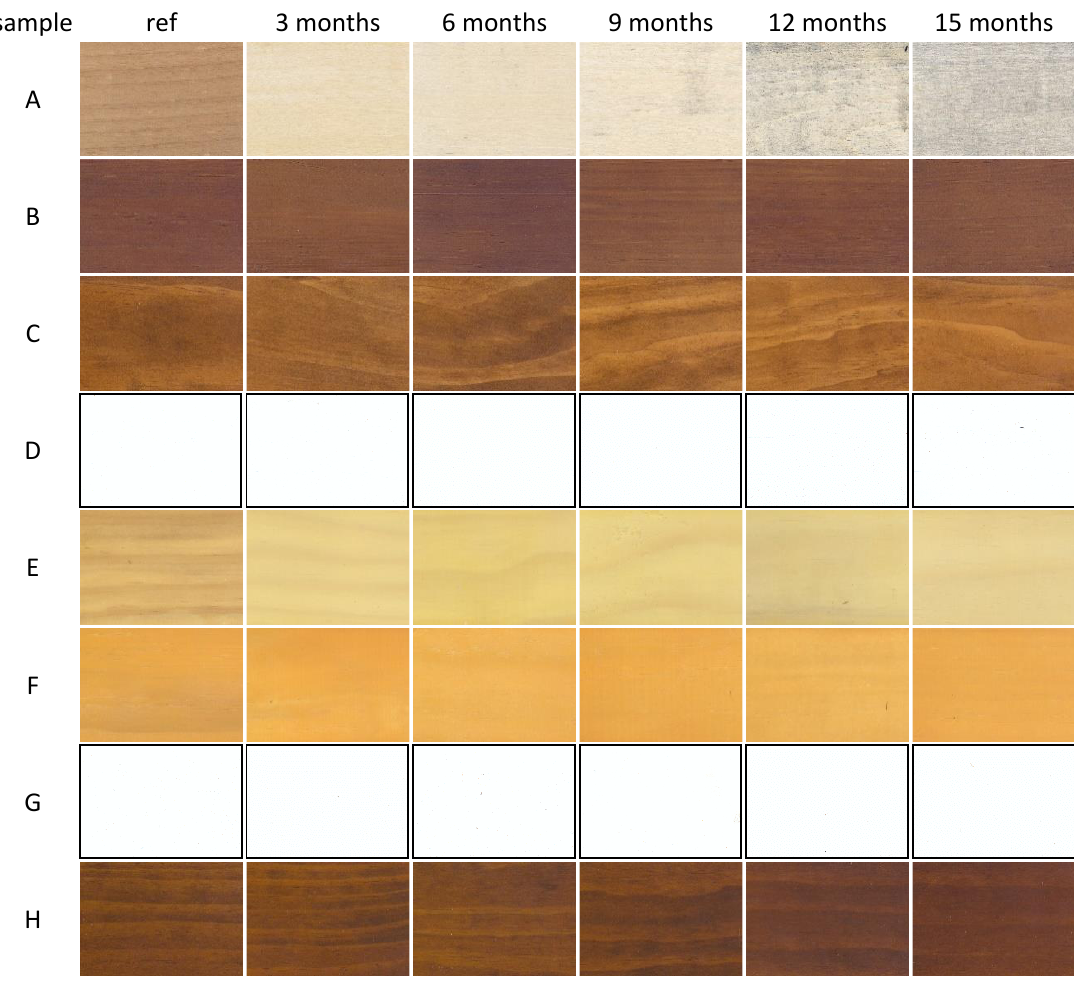
Figure 1. Macro colour images of acetylated wood samples exposed to natural